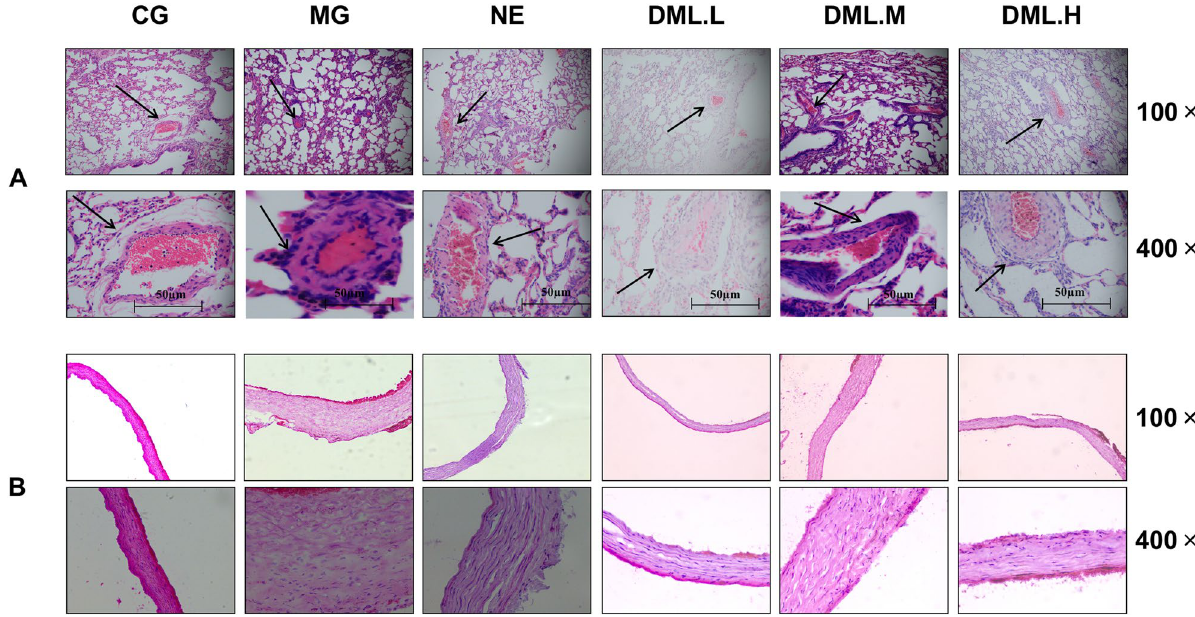
Figure 2. Histological assessment. ( A ) Representative micrographs of H&E staining of the lung tissue (100 × and 400 ×). Arrowheads indicate small pulmonary arteries < 100 µm in external diameter. ( B ) Representative micrographs of H&E staining of the pulmonary artery (100 × and 400 ×).